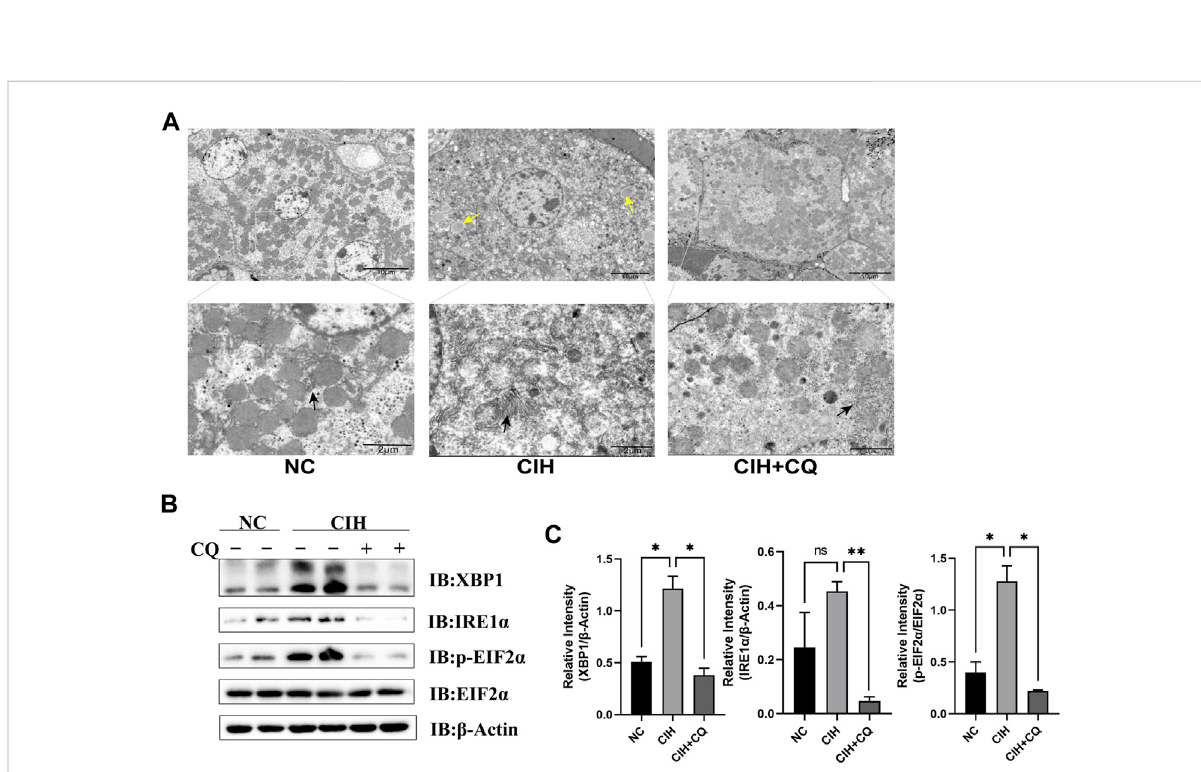
FIGURE 5 Inhibition of autophagic fl ux alleviated hepatocyte ER stress and LD accumulation. (A) Changes in ER morphology and LD accumulation in different groups were assessed. (B) Hepatic XBP1, IRE1 α , and EIF2 α protein levels were compared among groups. (C) XBP1 and IRE1 α protein levels were normalized based on β -Actin levels, and the p-EIF2 α /EIF2 α ratio was compared among groups. (Yellow arrow: LDs; black arrow: ER; * p < 0.05, ** p < 0.01, ns: no statistical